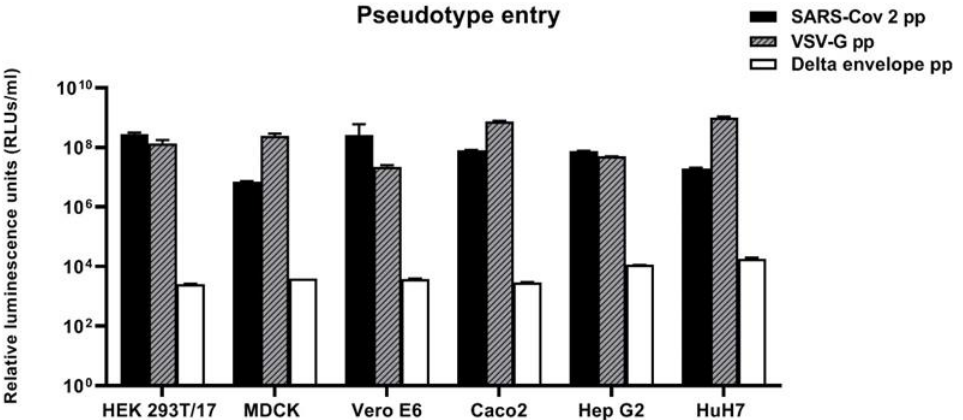
Figure 4. Susceptibility of cell lines to SARS-COV-2 driven entry. Cell lines of human and animal origin infected with ∆ -envelope pseudotypes, SARS-COV-2 pseudotypes and VSV-G pseudotypes. At 72 h post-infection, pseudotype entry was analysed by determining luciferase activity in cell lysates. Cell background without pseudotypes infection was used for normalisation. Values are expressed as the means of independent results ± SD ( n = 3). Two-way analysis of variance (ANOVA) test was used for statistical analysis.